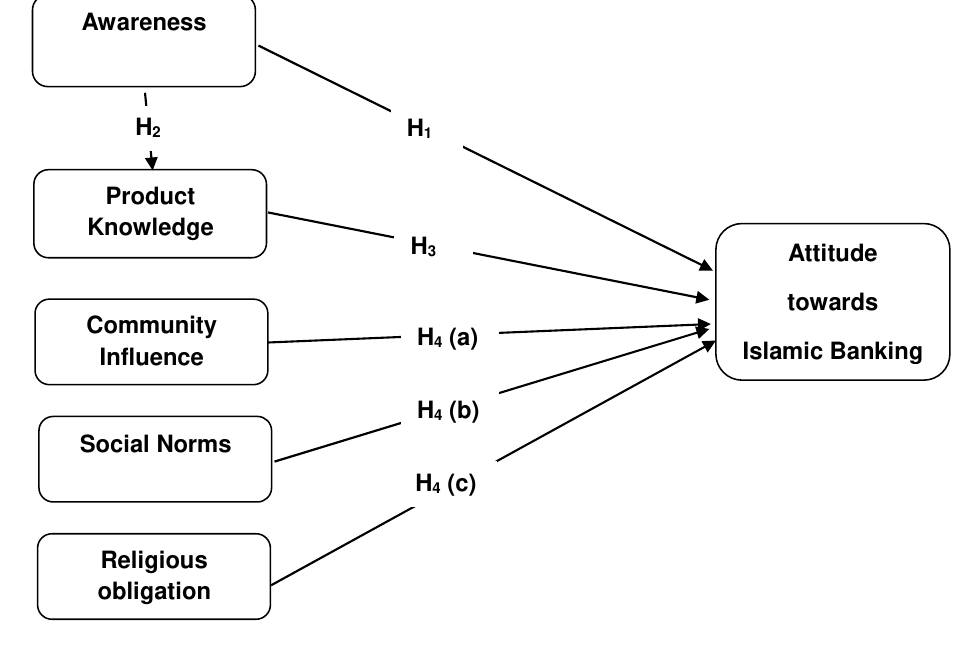
Fig. 1. Proposed conceptual